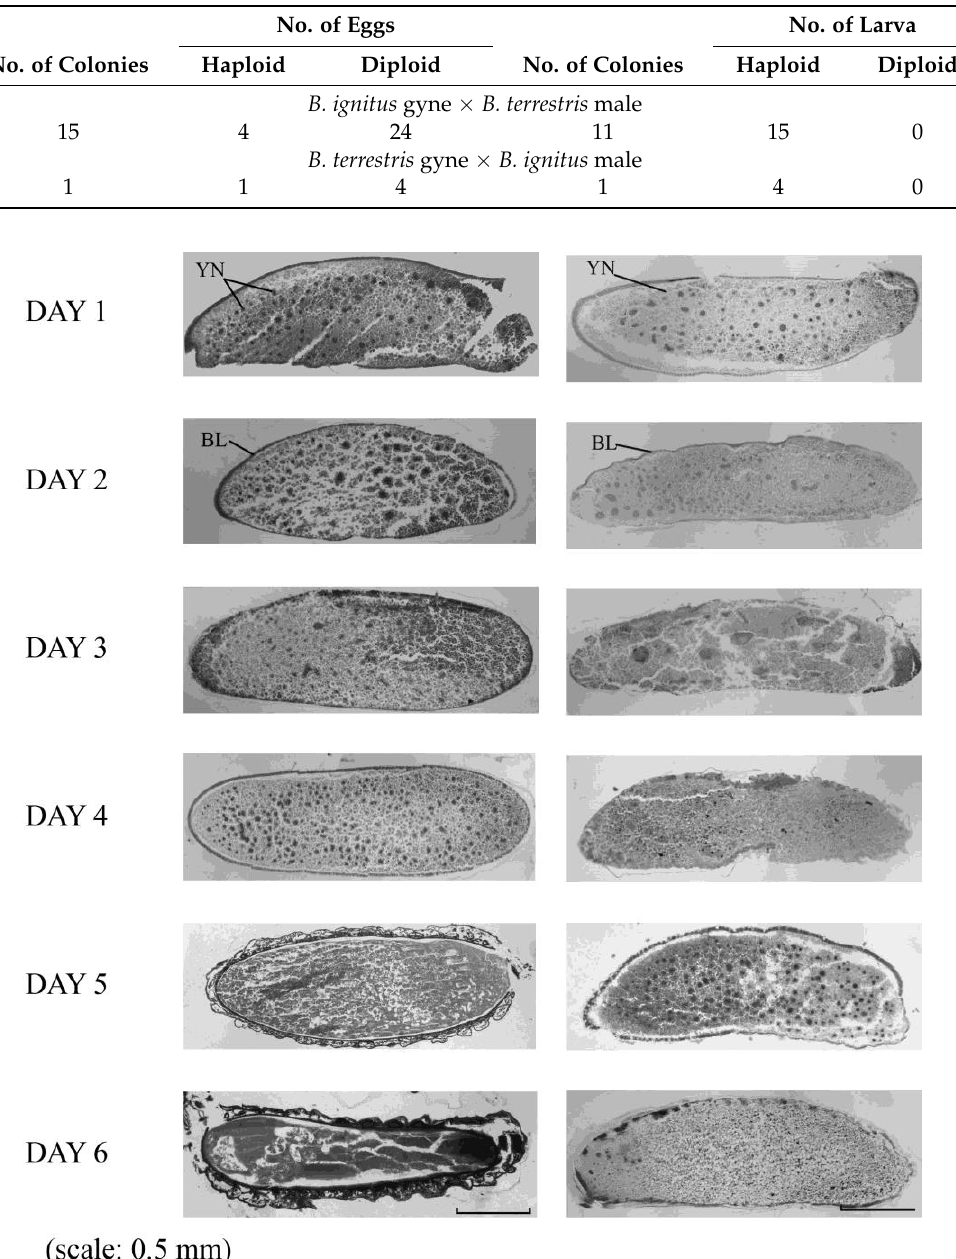
Table 2. Sex of eggs and larvae for each colony headed by a single queen, as revealed by microsatellite genotyping.